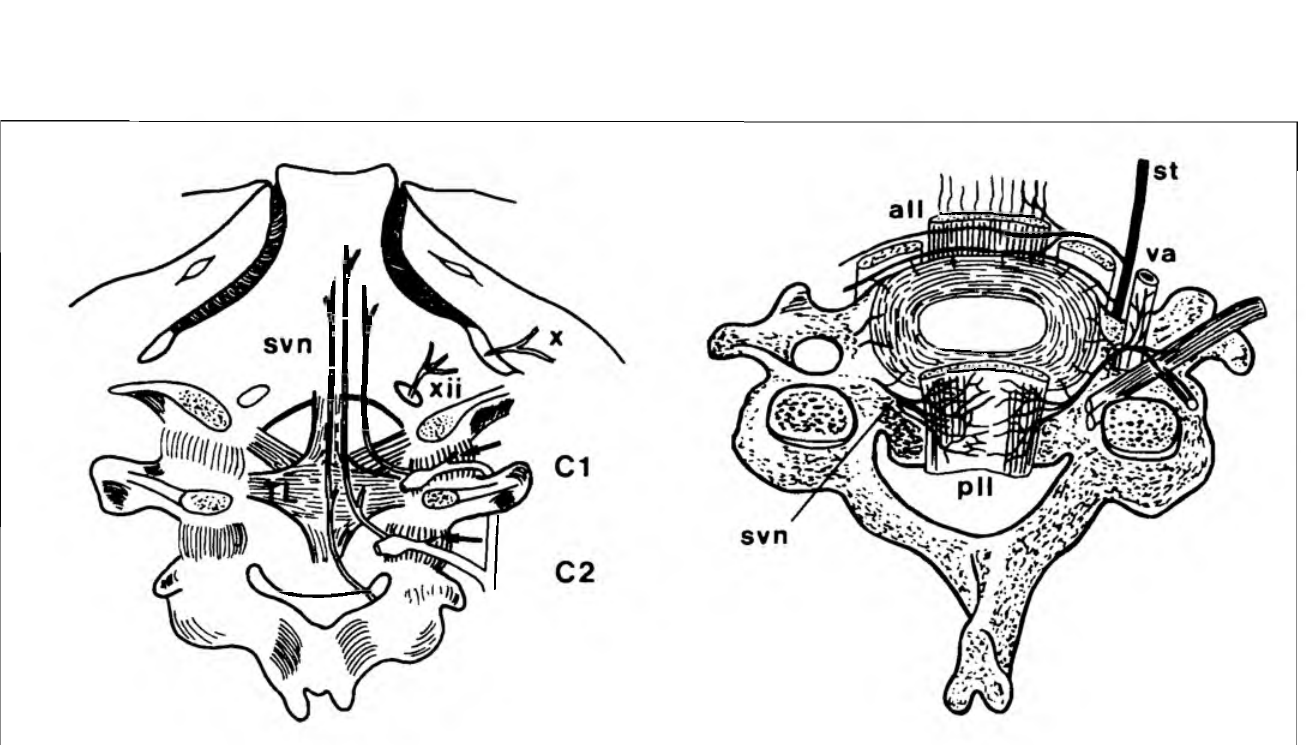
Fig 4: Distribution of the upper three cervical sinuvertebral nerves and the innervation of the atlanto-occipital and atlantoaxial joints. Articular branches (arrowed) to the atlanto-occipital and atlantoaxial joints arise from the Cl and C2 ventral rami, respectively.